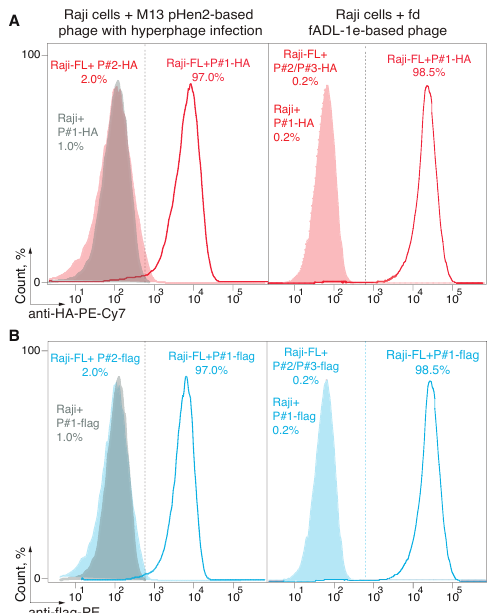
Figure 2. Detection of the receptor-ligand interaction with the fADL-1e-based and pHen2-produced bacteriophages. Ligand–receptor interaction was studied by the flow cytometry using Raji cells expressing a membrane-tethered BCR in a single-chain format (Raji-FL cells), and filamentous bacteriophages carrying its peptide ligand (P#1). Non-transduced Raji and Raji-FL cells were incubated with filamentous phages exposing P#1-peptide fused with HA-tag ( A ) or 3xFLAG ( B ) at a concentration of 1 × 10 12 or 5 × 10 12 phage particles per mL for fADL-1e-based ( right ) or pHen2-based ( left ) protocols, respectively. Phages exposing irrelevant P#2 and P#3 peptides were used as a negative control. Fluorescence signals are plotted on the x -axis, and the percentage of the recorded events is on the y -axis. Histograms for pHen2-based + hyperphage system ( left ) show the cut-o ff gate at a false-positive signal level of 2%. Histograms for fADL-1e-based ( right ) show the cut-o ff gate at a false-positive signal level of